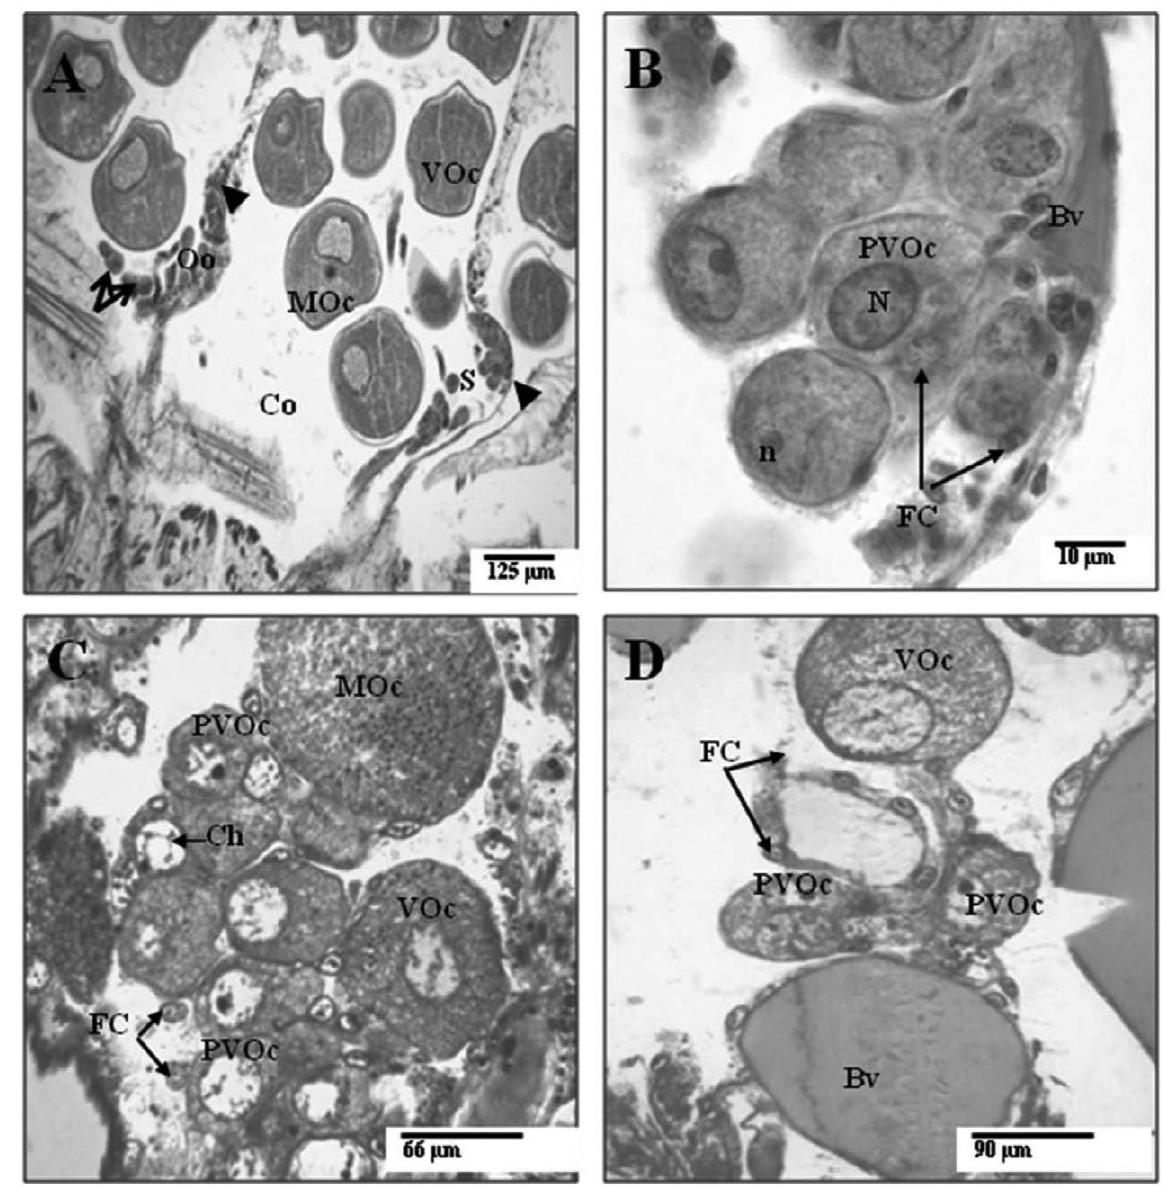
Fig. 2. – A, light micrograph of clusters of germ cells containing oogonia (Oo) and primary oocytes (arrows) within germinal sac (S); each packet is enveloped by a thin layer of somatic cell (arrowhead); note free vitellogenic and mature oocytes in the coelom. B, light micrograph of a cluster of germ cells attached to a blood vessel (Bv); note packets of follicle cells (FC) (arrows) surrounding previtellogenic oocytes (PVOc). C and D, light micrographs showing oocytes in various stages of meiotic division. Ch, chromatin; Co, coelom; MOc, mature oocyte; n, nucleolus; N, nucleus; VOc, vitellogenic